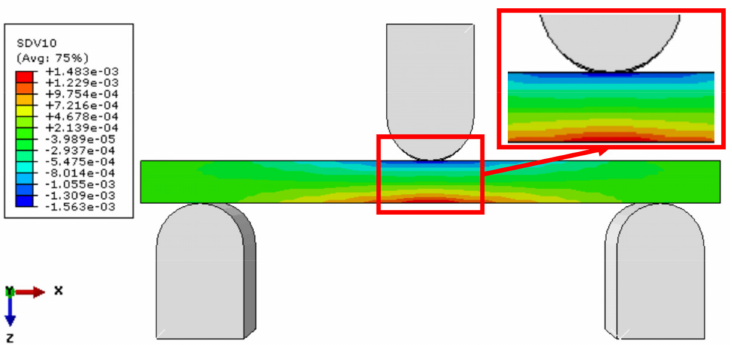
Figure 11. The ε xx on the sample